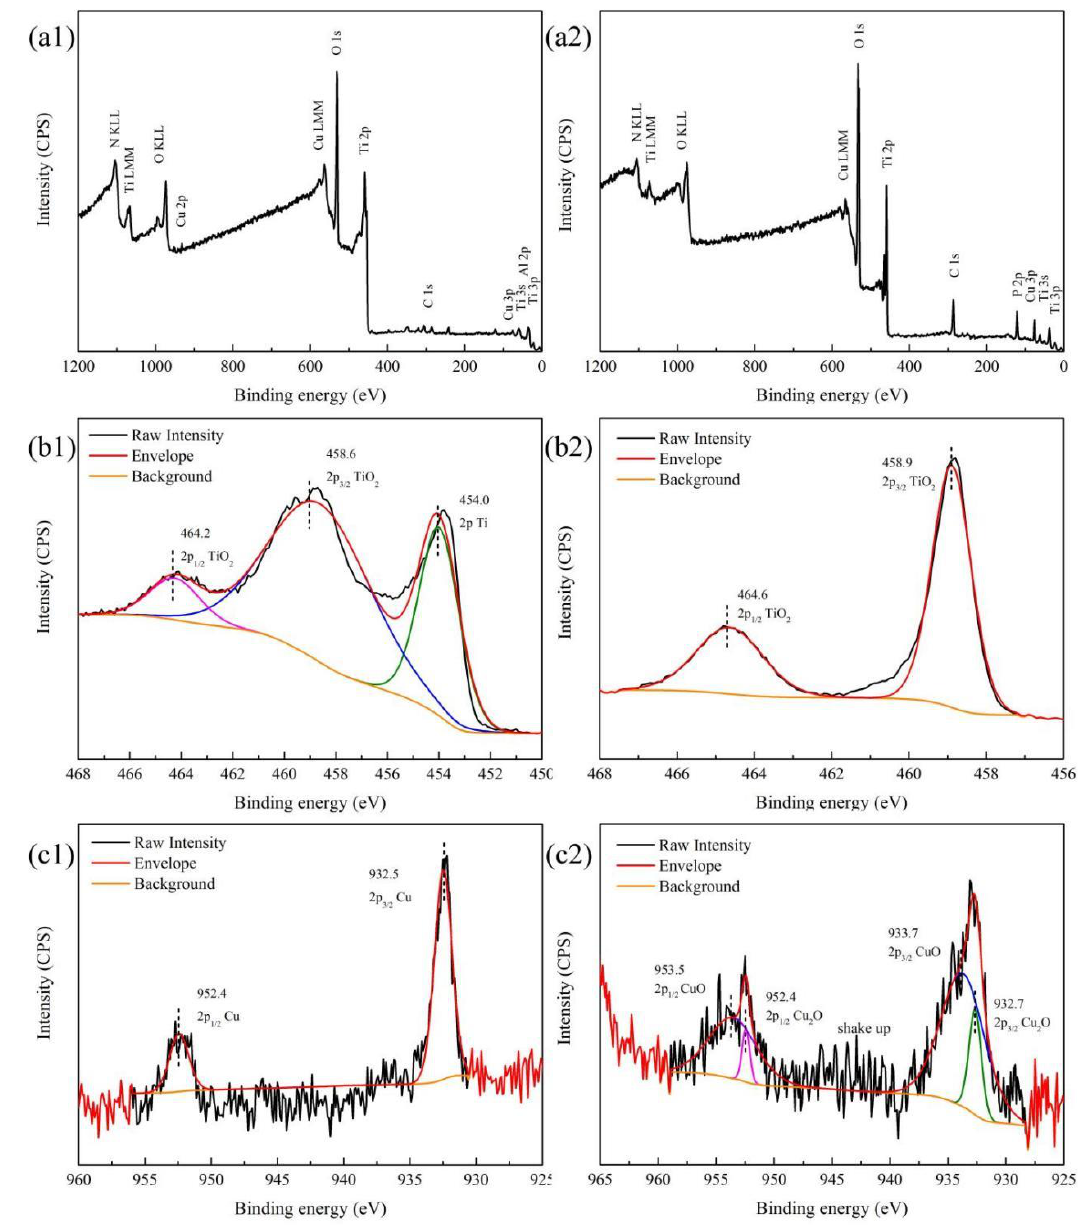
Figure 3. XPS analysis of Ti-Cu-S and Ti-Cu-SA samples ( a1 ) Full spectrum of Ti-Cu-S alloy; ( a2 ) Full spectrum of Ti-Cu-SA alloy; ( b1 )Ti 2p of Ti-Cu-S alloy; ( b2 ) Ti 2p of Ti-Cu-SA alloy; ( c1 ) Cu 2p of Ti-Cu-S alloy; ( c2 ) Cu 2p of Ti-Cu-SA alloy.